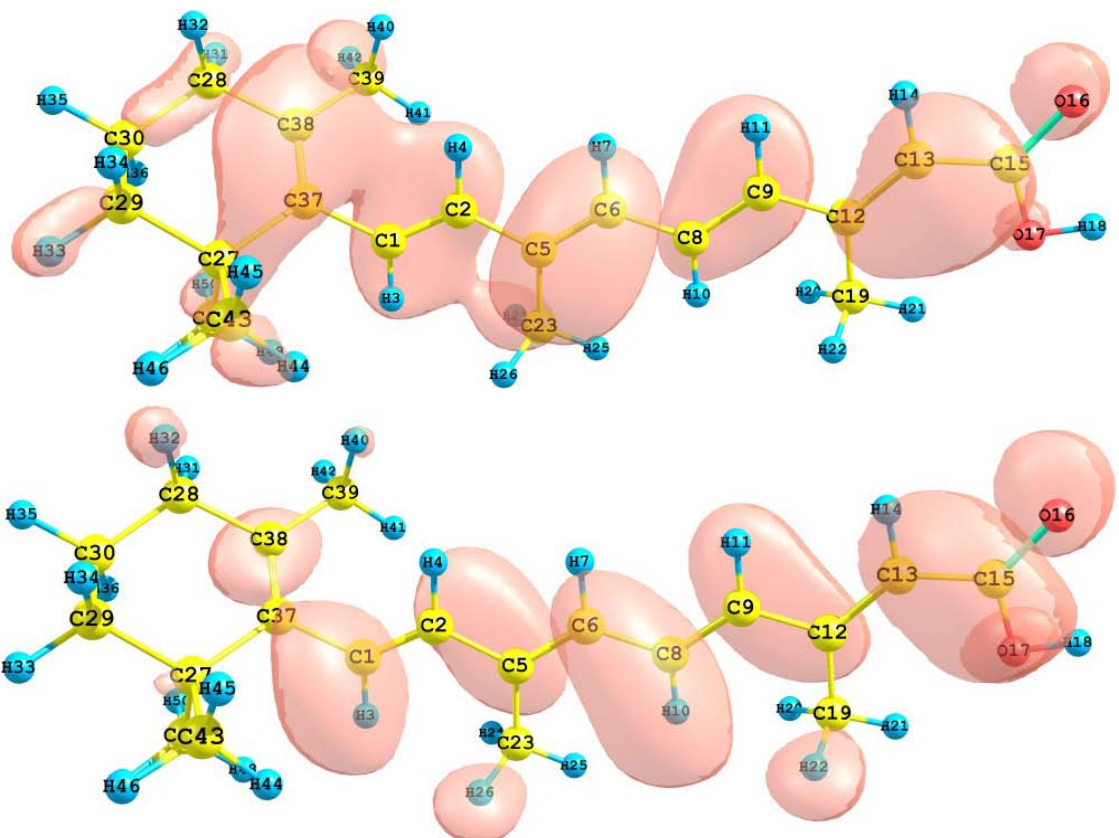
Figure 10. HOMO and LUMO of the retinoic acid molecule calculated with the M05- 2X/6-31+G(d,p) level of